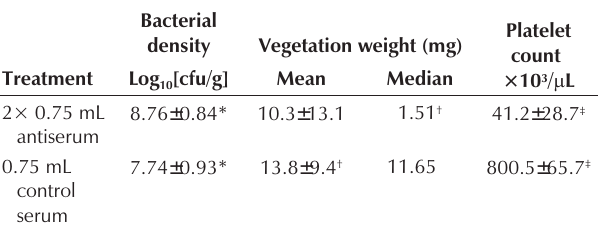
TABLE 2 Effects on streptococcal endocarditis model of two-dose antithrombocyte treatment